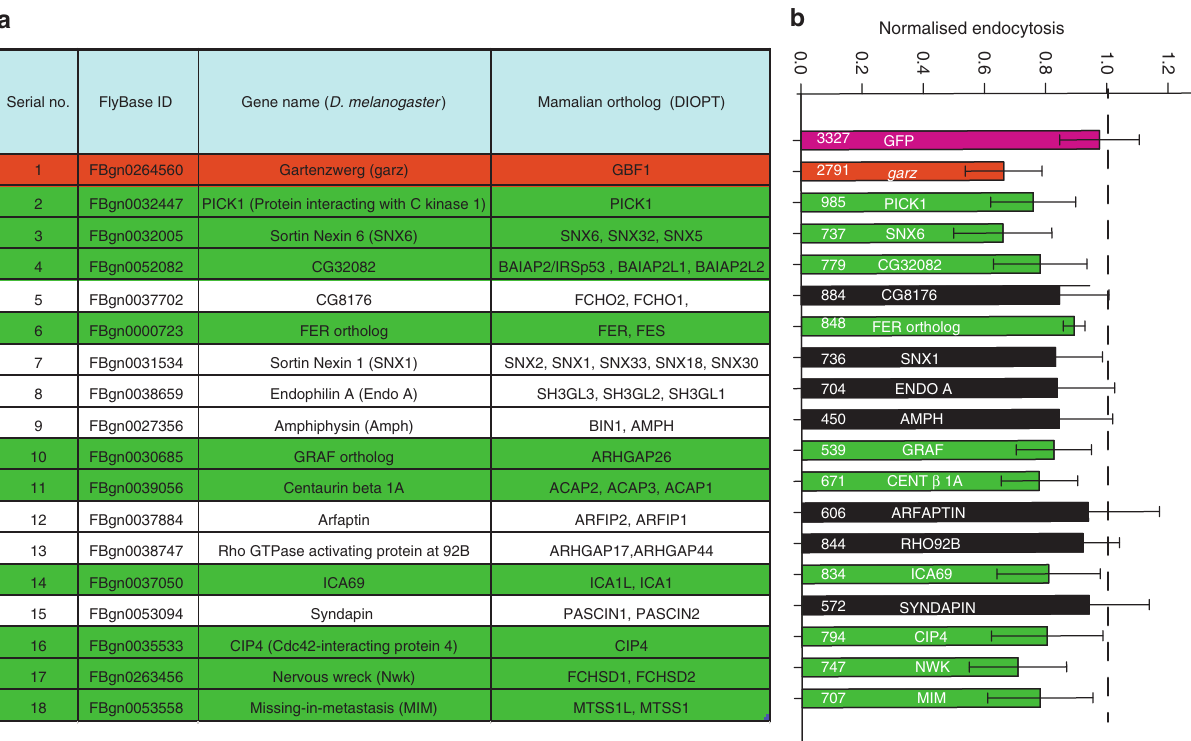
Fig. 2 RNAi screen reveals BAR domain proteins involved in CG endocytosis. a List of Drosophila proteins in the PFAM database that contained one of the following BAR domains, PFAM IDs — PF06456, PF09325, PF06456, PF00611 and PF08397. The list was fi ltered to remove duplicates to give 18 genes. b The histogram shows normalised 5-min fl uid-phase uptake in S2R + cells treated with 10 µ g of dsRNA for 4 days as indicated with dsRNA against GBF1 ( garz ) as positive, and GFP as negative controls. In a single experiment, mean uptake of one of GFP dsRNA coverslip was used to normalise the mean for rest of the coverslips. Data were pooled from three independent experiments and the cell numbers are indicated in the graph. The bars in green are signi fi cantly different from GFP dsRNA using two-sample t -test ( p value <0.05). Version 27 of the PFAM database was used to generate